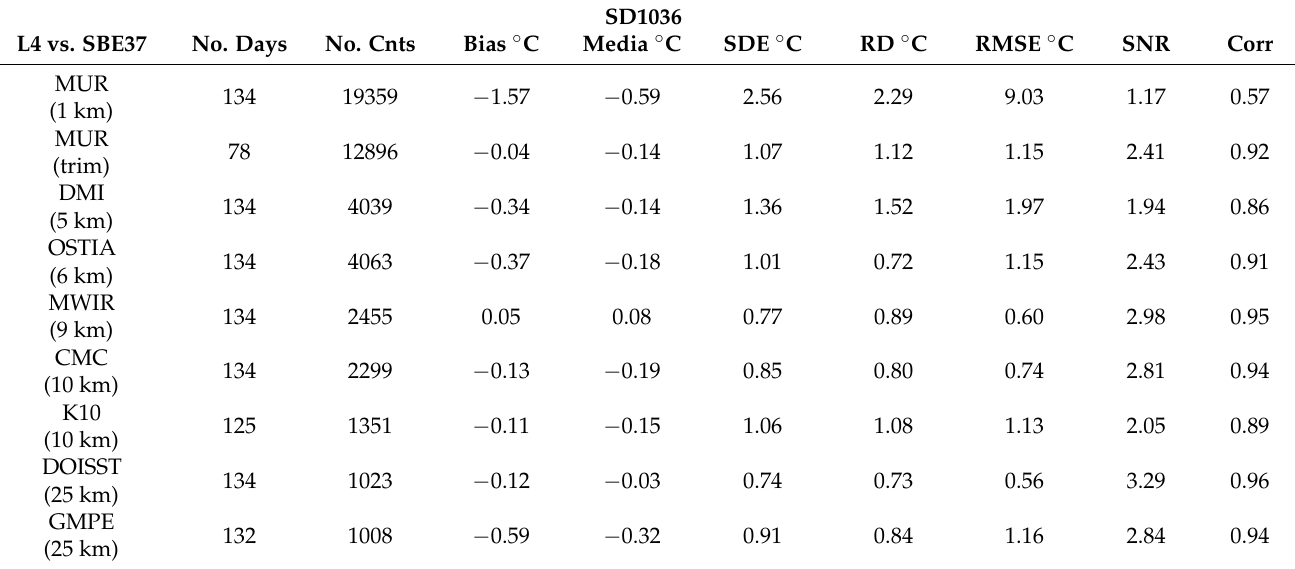
Table 2. Statistics for GHRSST L4 vs. saildrone SBE37 on SD1036 deployment.